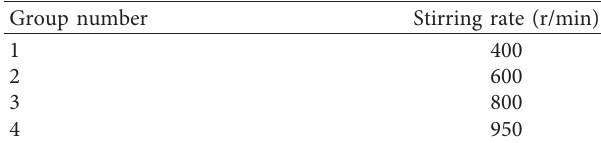
Table 1: Corresponding stirring rate for each group. Group number